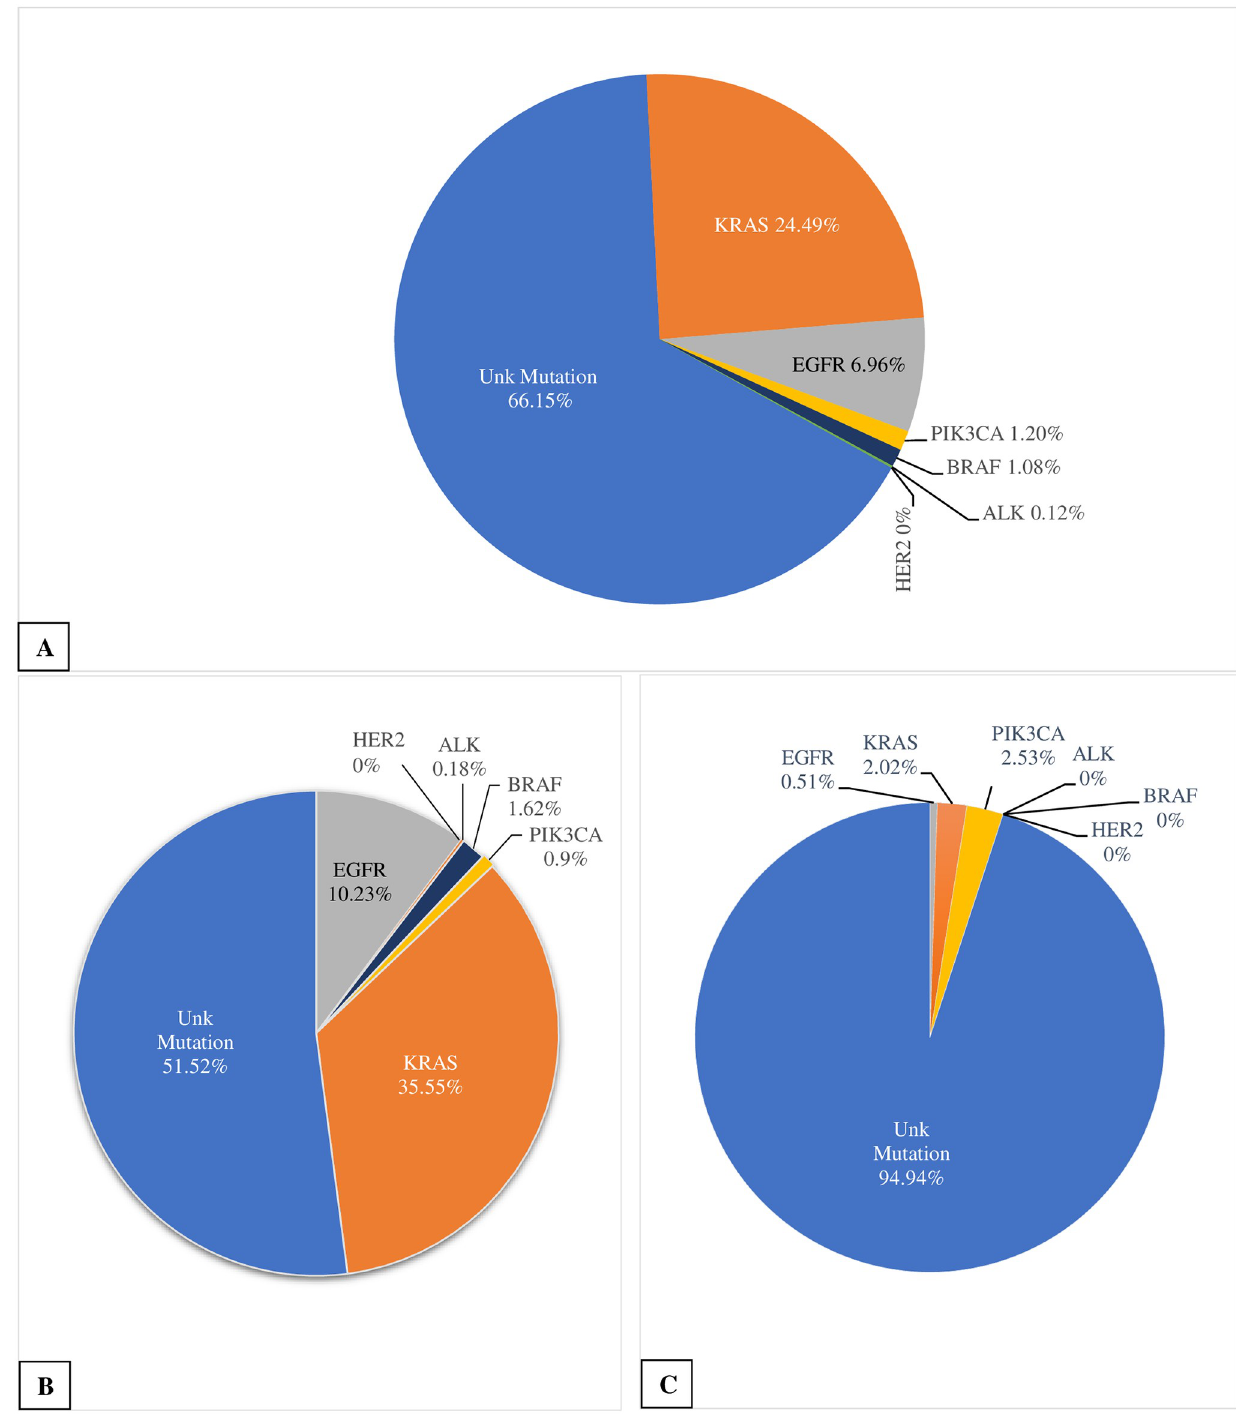
Fig 1. Mutation frequencies. A. Frequency of the mutations within the 833 samples tested. B. Frequency of the mutations with the 557 adenocarcinoma samples tested. C. Frequency of the mutations with the 198 squamous cell carcinoma samples tested.